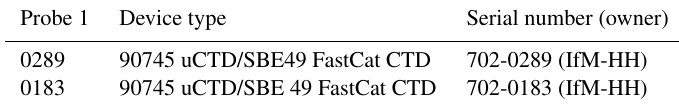
Table 3. Used uCTD sensors.